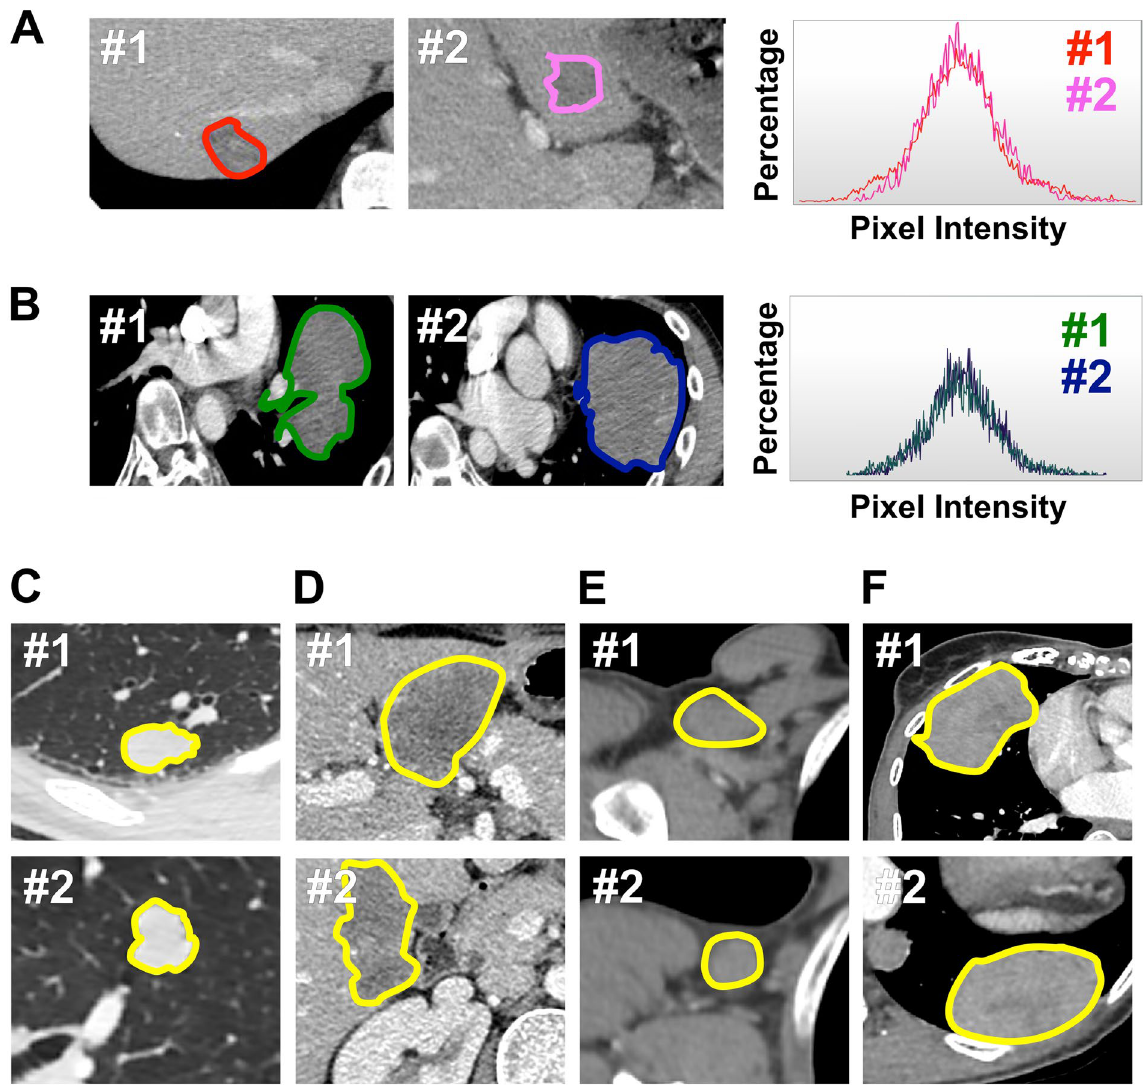
Figure 1. Comparing the imaging phenotype of paired biopsy-proven synchronous metastases. In each patient (n = 112), we compared the imaging phenotype of two biopsy-proven synchronous metastases (#1 vs. #2) from the same primary tumor and within the same organ. Patients ( A–F ) demonstrate the similarity of imaging phenotype between two synchronous metastases captured by trained radiologists (picture #1 and #2) and by TexRAD software (histogram #1 vs.